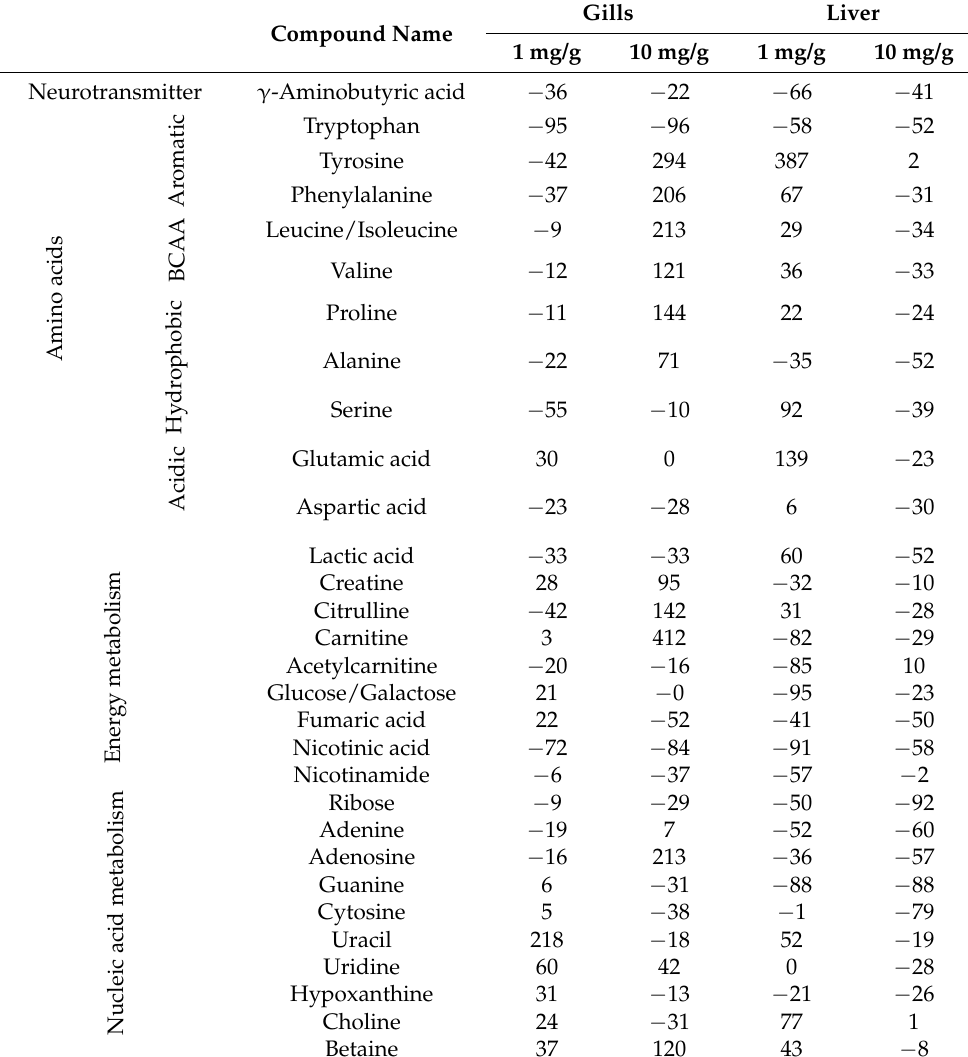
Table 1. Fold changes (%) of metabolites between the exposed and control in the perch gills and liver (for 1 mg/g and 10 mg/g MP particles in